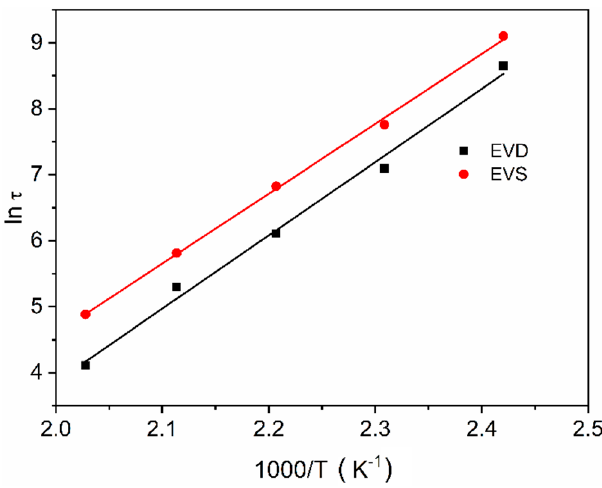
Figure 7. Linear fitting of the relaxation time versus temperature according to the Arrhenius equation for relaxation activation energy determination.